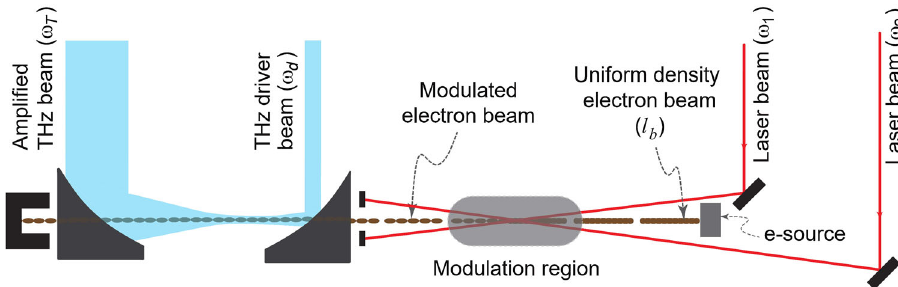
FIG. 1. The proposed layout of the interaction. The electron beam is modulated by the ponderomotive force induced by the lasers beat wave. Whereafter, the modulated electron beam interacts with a chirped-frequency low-amplitude driver wave at terahertz frequency that drives a nonlinear transverse current of electrons. The nonlinear oscillations of electrons will then emit high-intensity terahertz